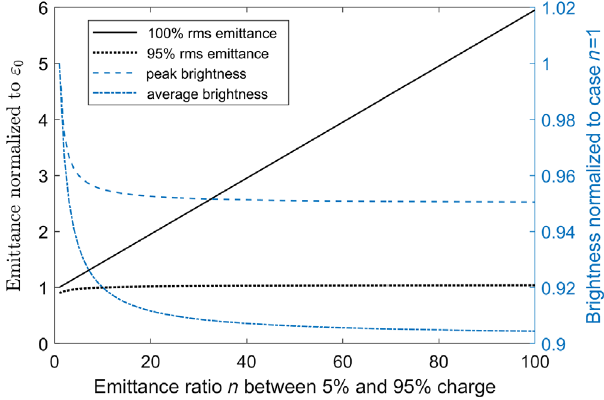
FIG. 1. rms emittance and beam brightness vs 5% charge emittance degradation according to Eq.